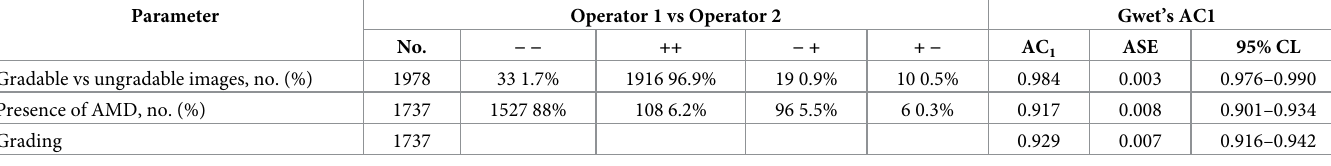
Table 3. Inter-operator agreement on OCT